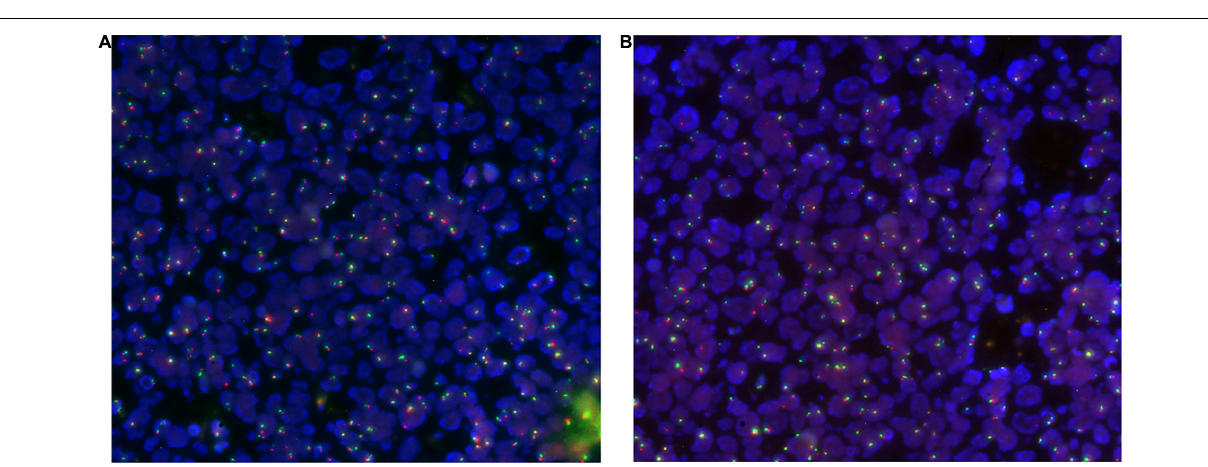
FIGURE 6 | Duodenal (A) and colonic (B) tissue hybridized with the EGFR/CEP7 probe: nuclei are highlighted in blue, red signals instead highlight the EGFR gene (7p11) while green signals highlight the centromere of chromosome 7